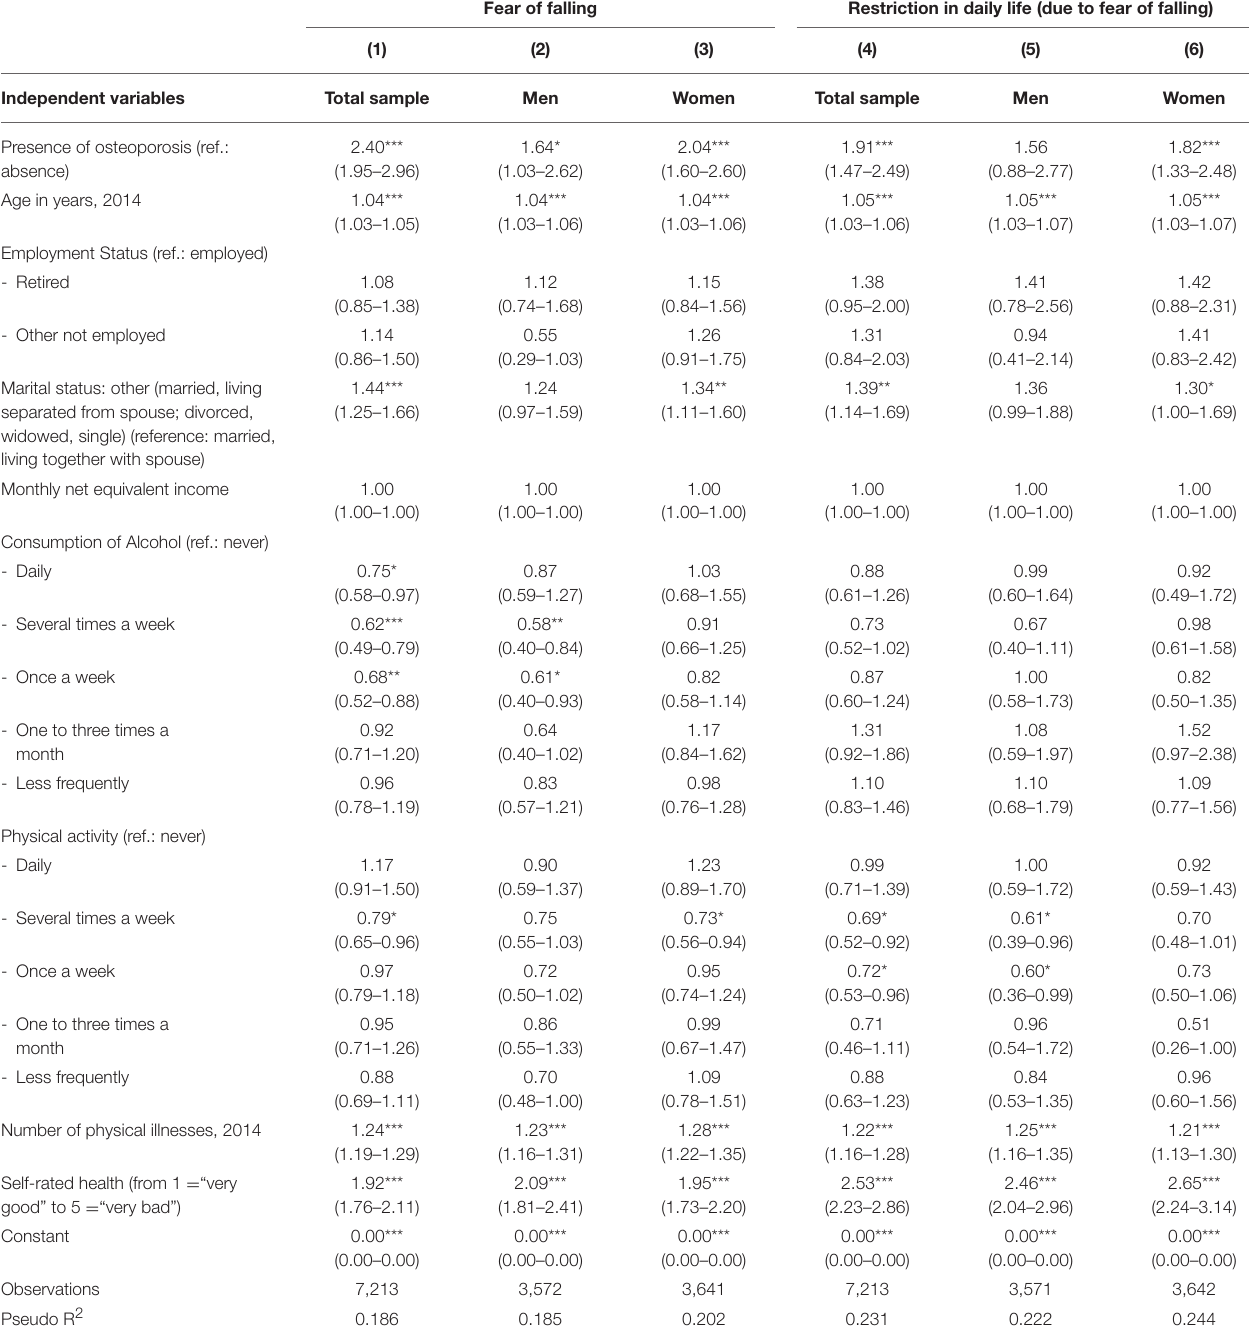
TABLE 2 | Determinants of fear of falling and restrictions in daily life due to fear of falling. Fear of falling Restriction in daily life (due to fear of falling)